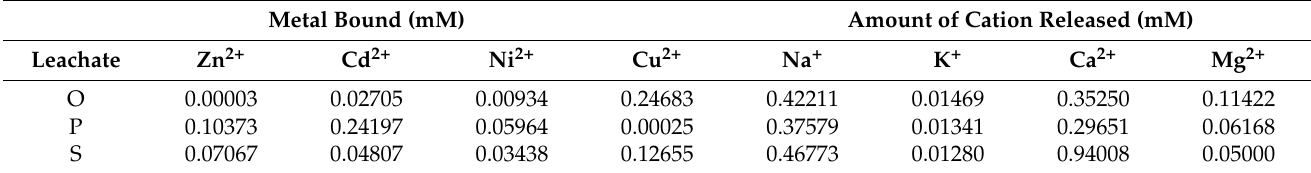
Table 8. Release of Na + , K + , Ca 2+ and Mg 2+ ions due to adsorption of Zn 2+ , Cd 2+ , Ni 2+ and Cu